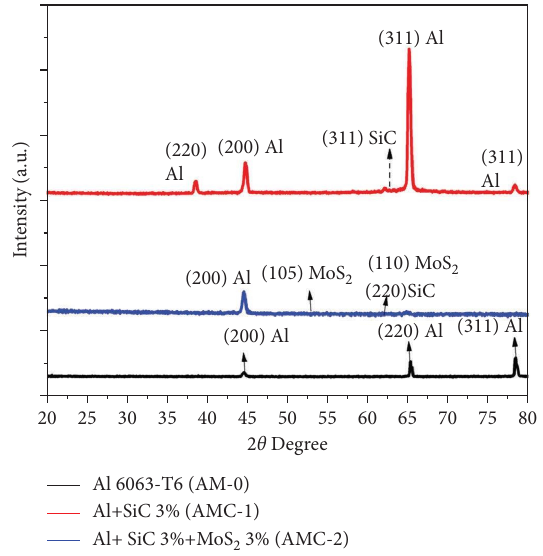
Figure 9: XRD patterns of AM-0 (Al 6063-T6), AMC-1 (Al6063+3%SiC), and AMC-2(Al6063 +3%SiC+3%MoS 2 )